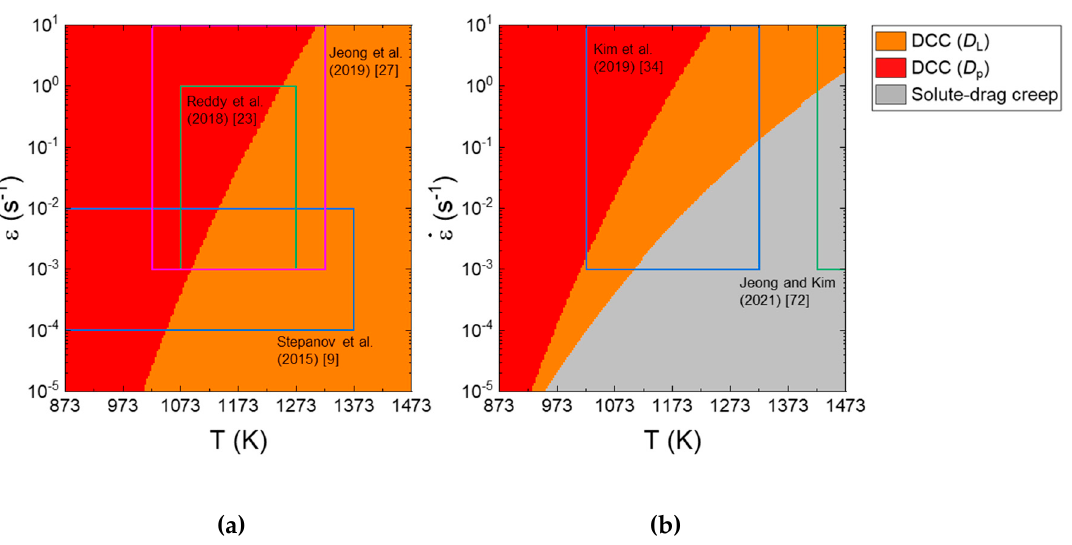
Figure 6. Deformation mechanism maps as a function of strain rate and temperature at a given grain size of 100 μ m for ( a ) CoCrFeMnNi and ( b ) Al 0.5 CoCrFeMnNi. Reproduced/modified with permission from [62], Elsevier.